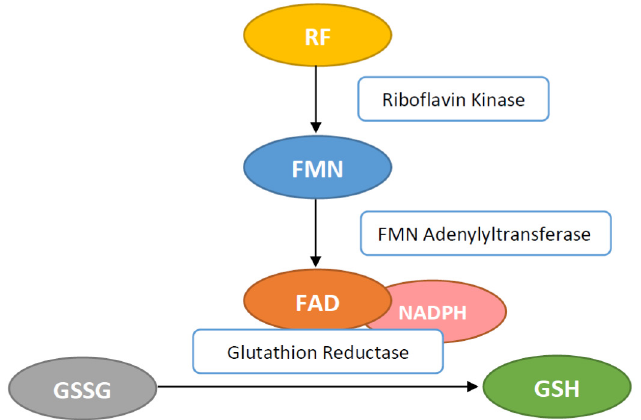
Figure 3. Flavin adenine dinucleotide (FAD) activates the glutathione reductase (GR) by transferring hydrogen for conversion of glutathione disulfide (GSSG) to glutathione (GSH).